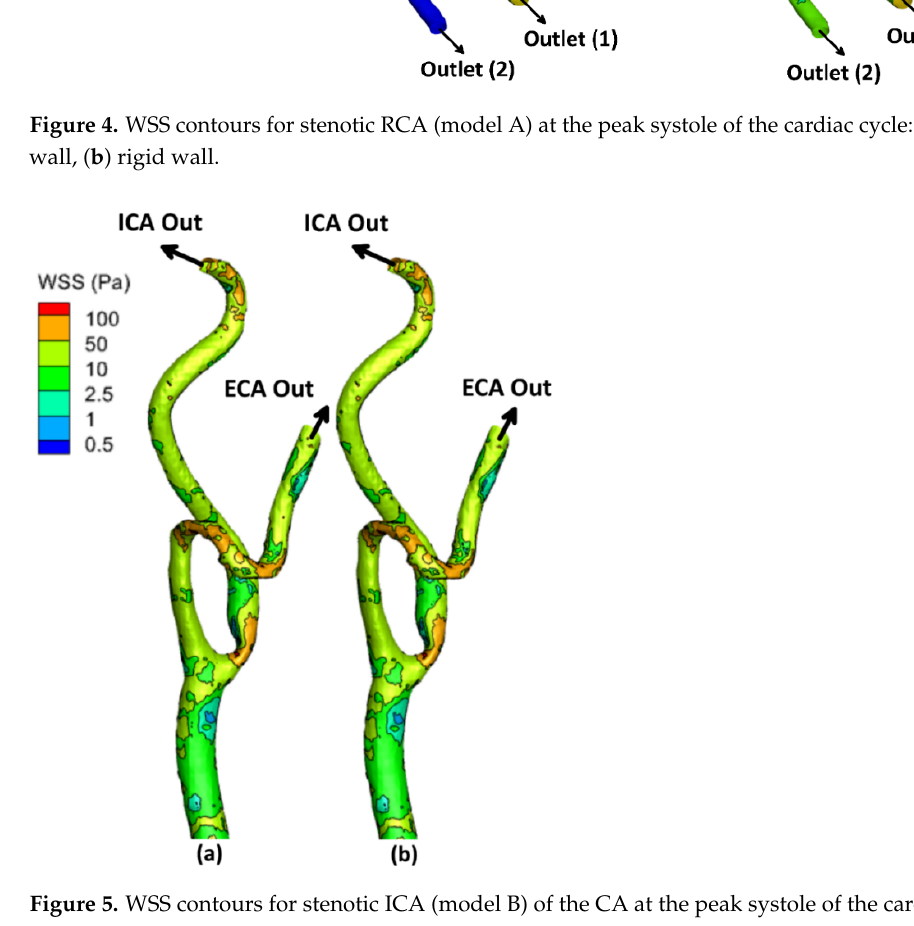
Figure 4. WSS contours for stenotic RCA (model A) at the peak systole of the cardiac cycle: ( a ) elastic wall, ( b ) rigid wall.